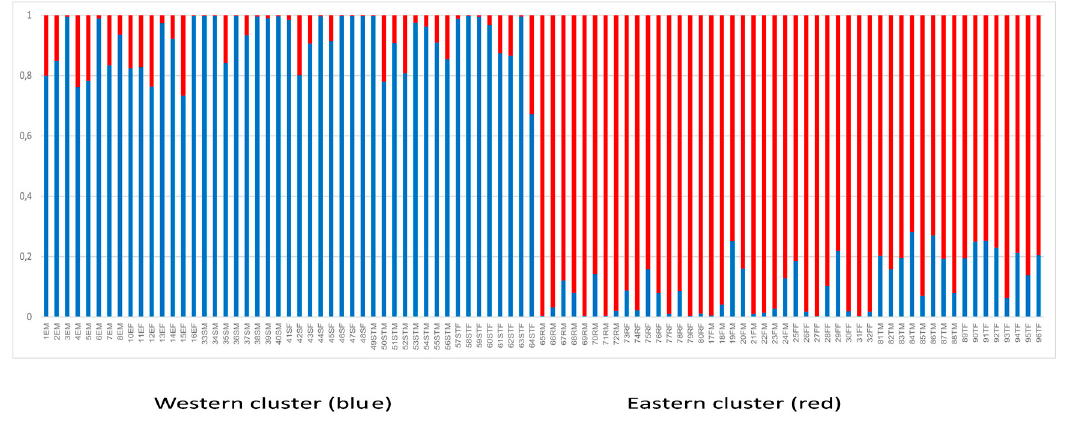
Figure 3. Population genetics structure analyses of all 95 individuals in the study using STRUCTURE software program. The insects are sorted according to Id number as in Supplementary Table S1 (blue: Western cluster and red: Eastern cluster).